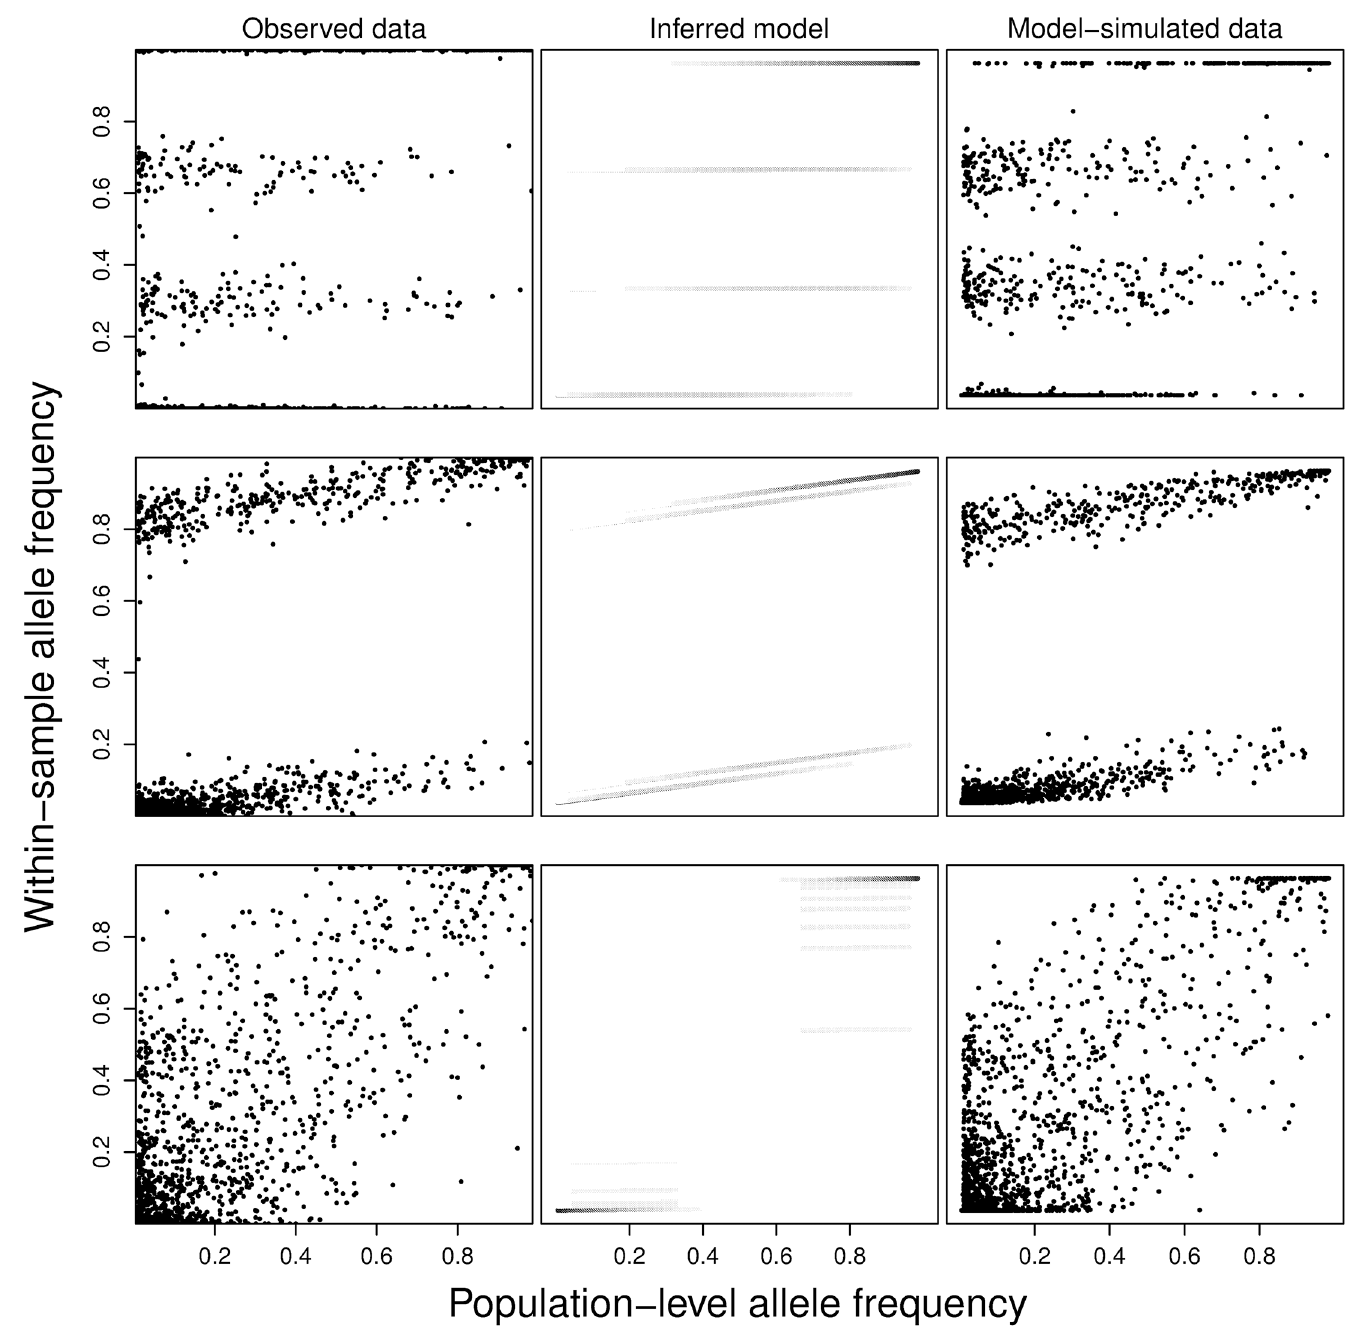
Fig 6. Examples of real and model-simulated data. For three samples (rows), we present the observed data WSAF plotted against the PLAF (first column), a diagram of the inferred model indicating the bands, proportions, and panmixia coefficient (second column), and data simulated under the inferred model. Panmixia coefficient and strain proportions are the MAP values. In the second column, the model ’ s PLAF-varying mixture densities are shown in grey scale, with black equal to one.